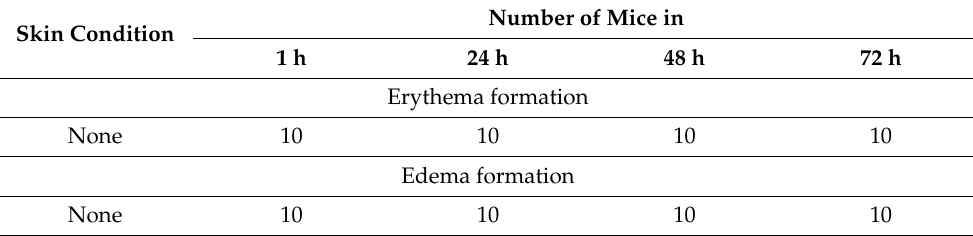
Table 5. Skin condition of experimental animals when applying the filtrate. Skin Condition